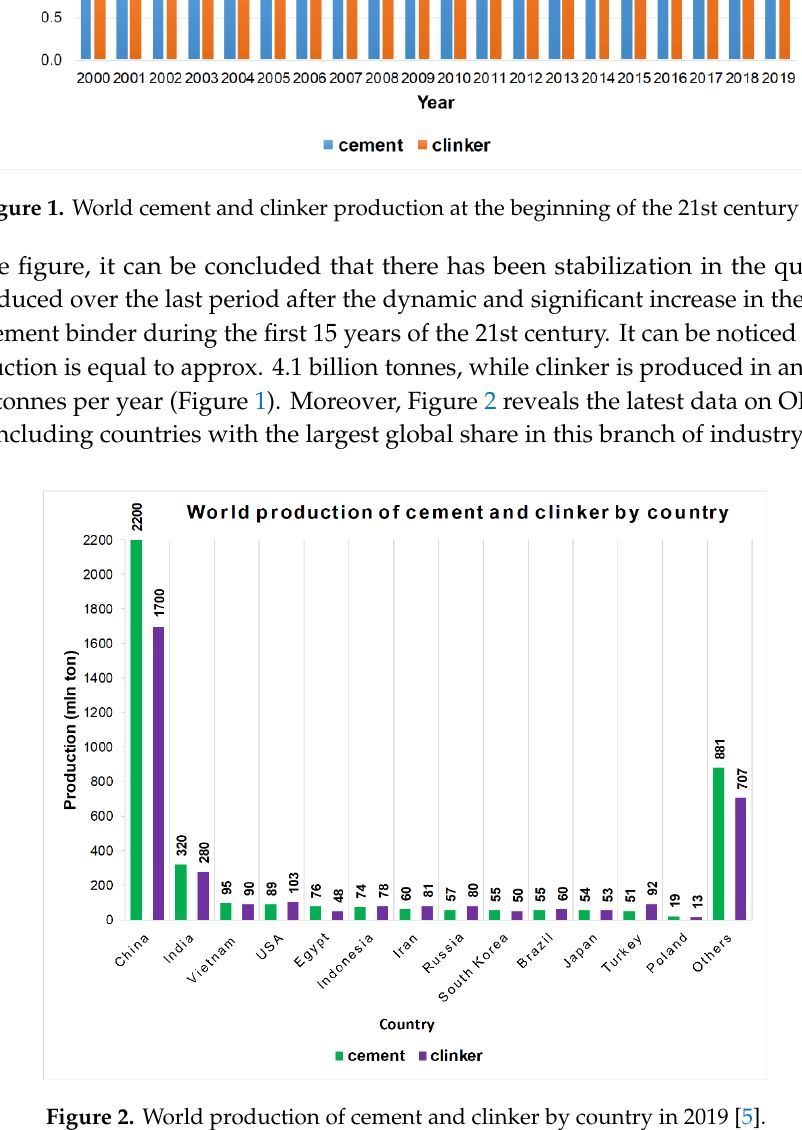
Figure 2. World production of cement and clinker by country in 2019